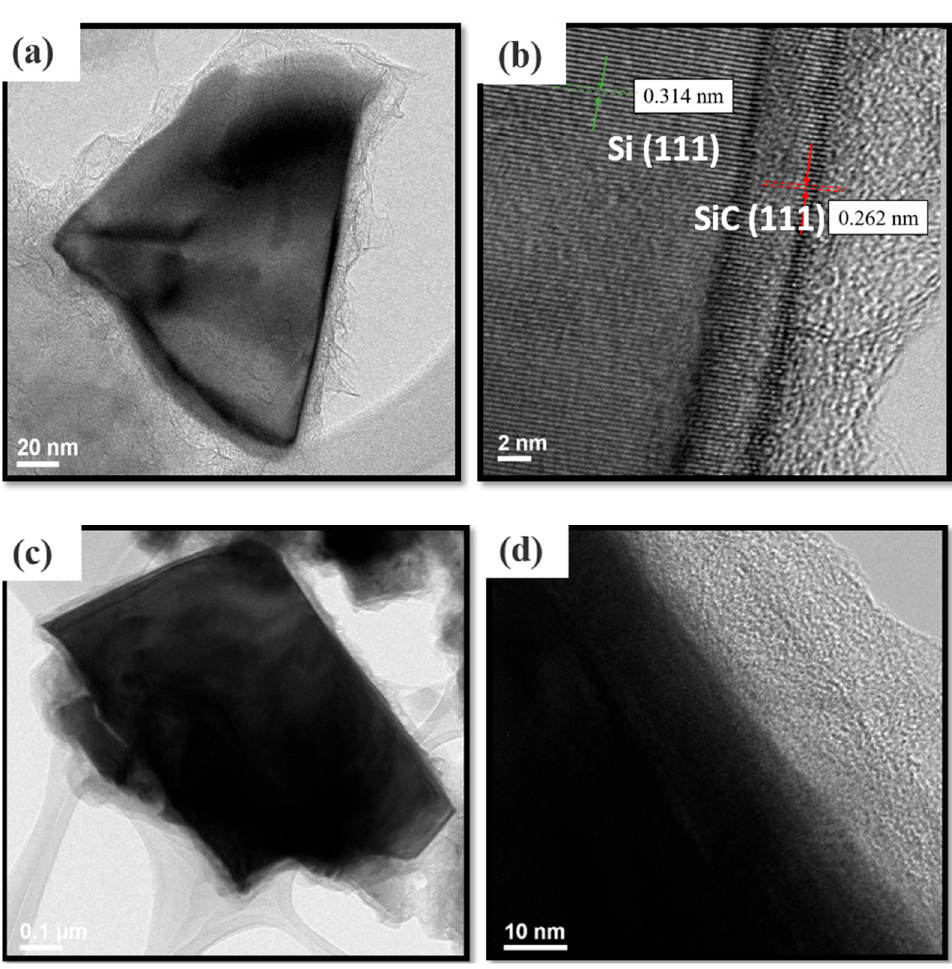
Figure 3. TEM images of a SiC coating on a pristine silicon flake ( a , b ) and an RF coating on SiC-coated silicon flake ( c , d ). Thermal carbonization of silicon flakes for SiC synthesis lasted for 5 h.